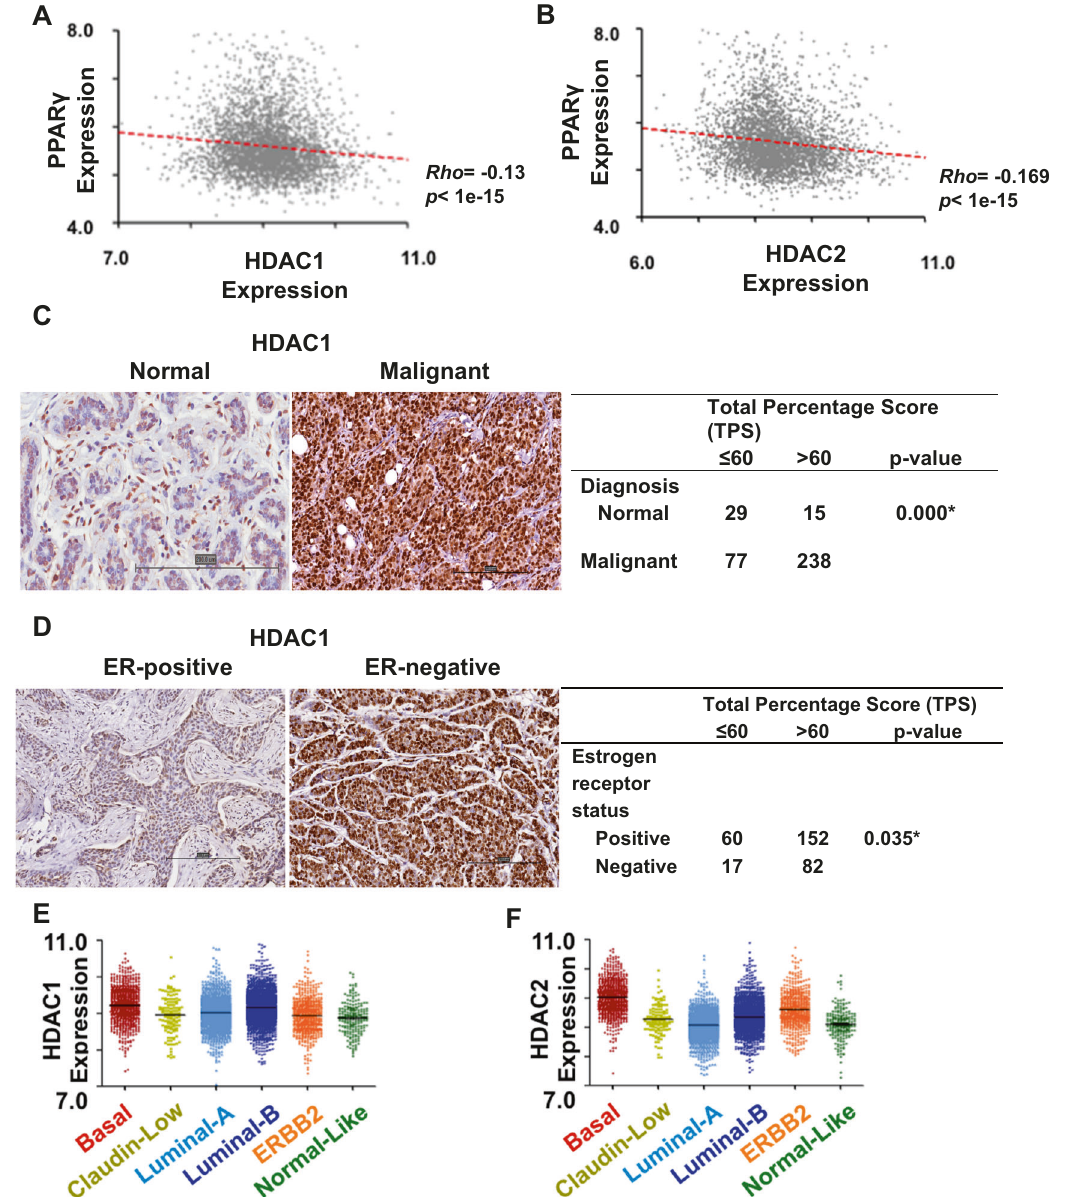
Fig. 1 HDAC and PPAR γ gene expression in breast cancer. A Correlation plot of PPAR γ and HDAC1 expression. B Correlation plot of PPAR γ and HDAC2 expression. A – B Spearman correlation test was performed, and the corresponding Rho and p values are shown next to the dot plots, n = 3992. C Left: HDAC1 immunostaining in normal and malignant tissues. A higher percentage of cells stained with HDAC1 was observed in malignant breast tissues compared to normal ductal tissues. Right: Statistics of HDAC1 expression between normal and malignant breast tissues. D Left: HDAC1 immunostaining in breast tissue showing nuclear localization. A higher percentage of cells stained with HDAC1 was observed in the IDC case having ER-negative status compared to the IDC case having ER-positive status. Right: Statistics of HDAC1 expression between IDC cases with ER-negative and positive statuses. E HDAC1 gene expression in breast cancer subtypes. F HDAC2 gene expression in breast cancer subtypes. E – F Color code: Basal, Maroon; Claudin-low, Yellow; Luminal-A, light blue; Luminal-B, dark blue; Normal-like, agonist/HDAC inhibitor combination therapy against angiogenesis determine whether this translates to any functional anti-angiogenic were abolished, thus con fi rming that the anti-vasculogenic effects effect. Combinatorial treatment using an HDAC inhibitor (LBH589) are mediated by PPAR γ activities (Fig. 3H and S5I – J). A chick and a PPAR γ agonist (rosiglitazone or ciglitazone) was found to chorioallantoic membrane (CAM) experiment was conducted to signi fi cantly curb the number of well-de fi ned capillary-like tubes and examine the effects of combination treatment on tumor vasculariza- branching points formed by human umbilical vein endothelial cells tion in vivo. Treatment of the MDA-MB-231 CAM tumor with LBH589 (HUVEC) [39] in an endothelial tube formation assay, compared with did not have any signi fi cant effects on the tumor volumes compared either of the monotherapies (Fig. 3G and S5G – H). Conversely, when to the DMSO control. However, a signi fi cant difference in vascular the assay was repeated by pre-treating the matrigel with a non- volume was observed from the combination treatment of 50 nM competitive PPAR γ antagonist, the synergistic effects of the PPAR γ